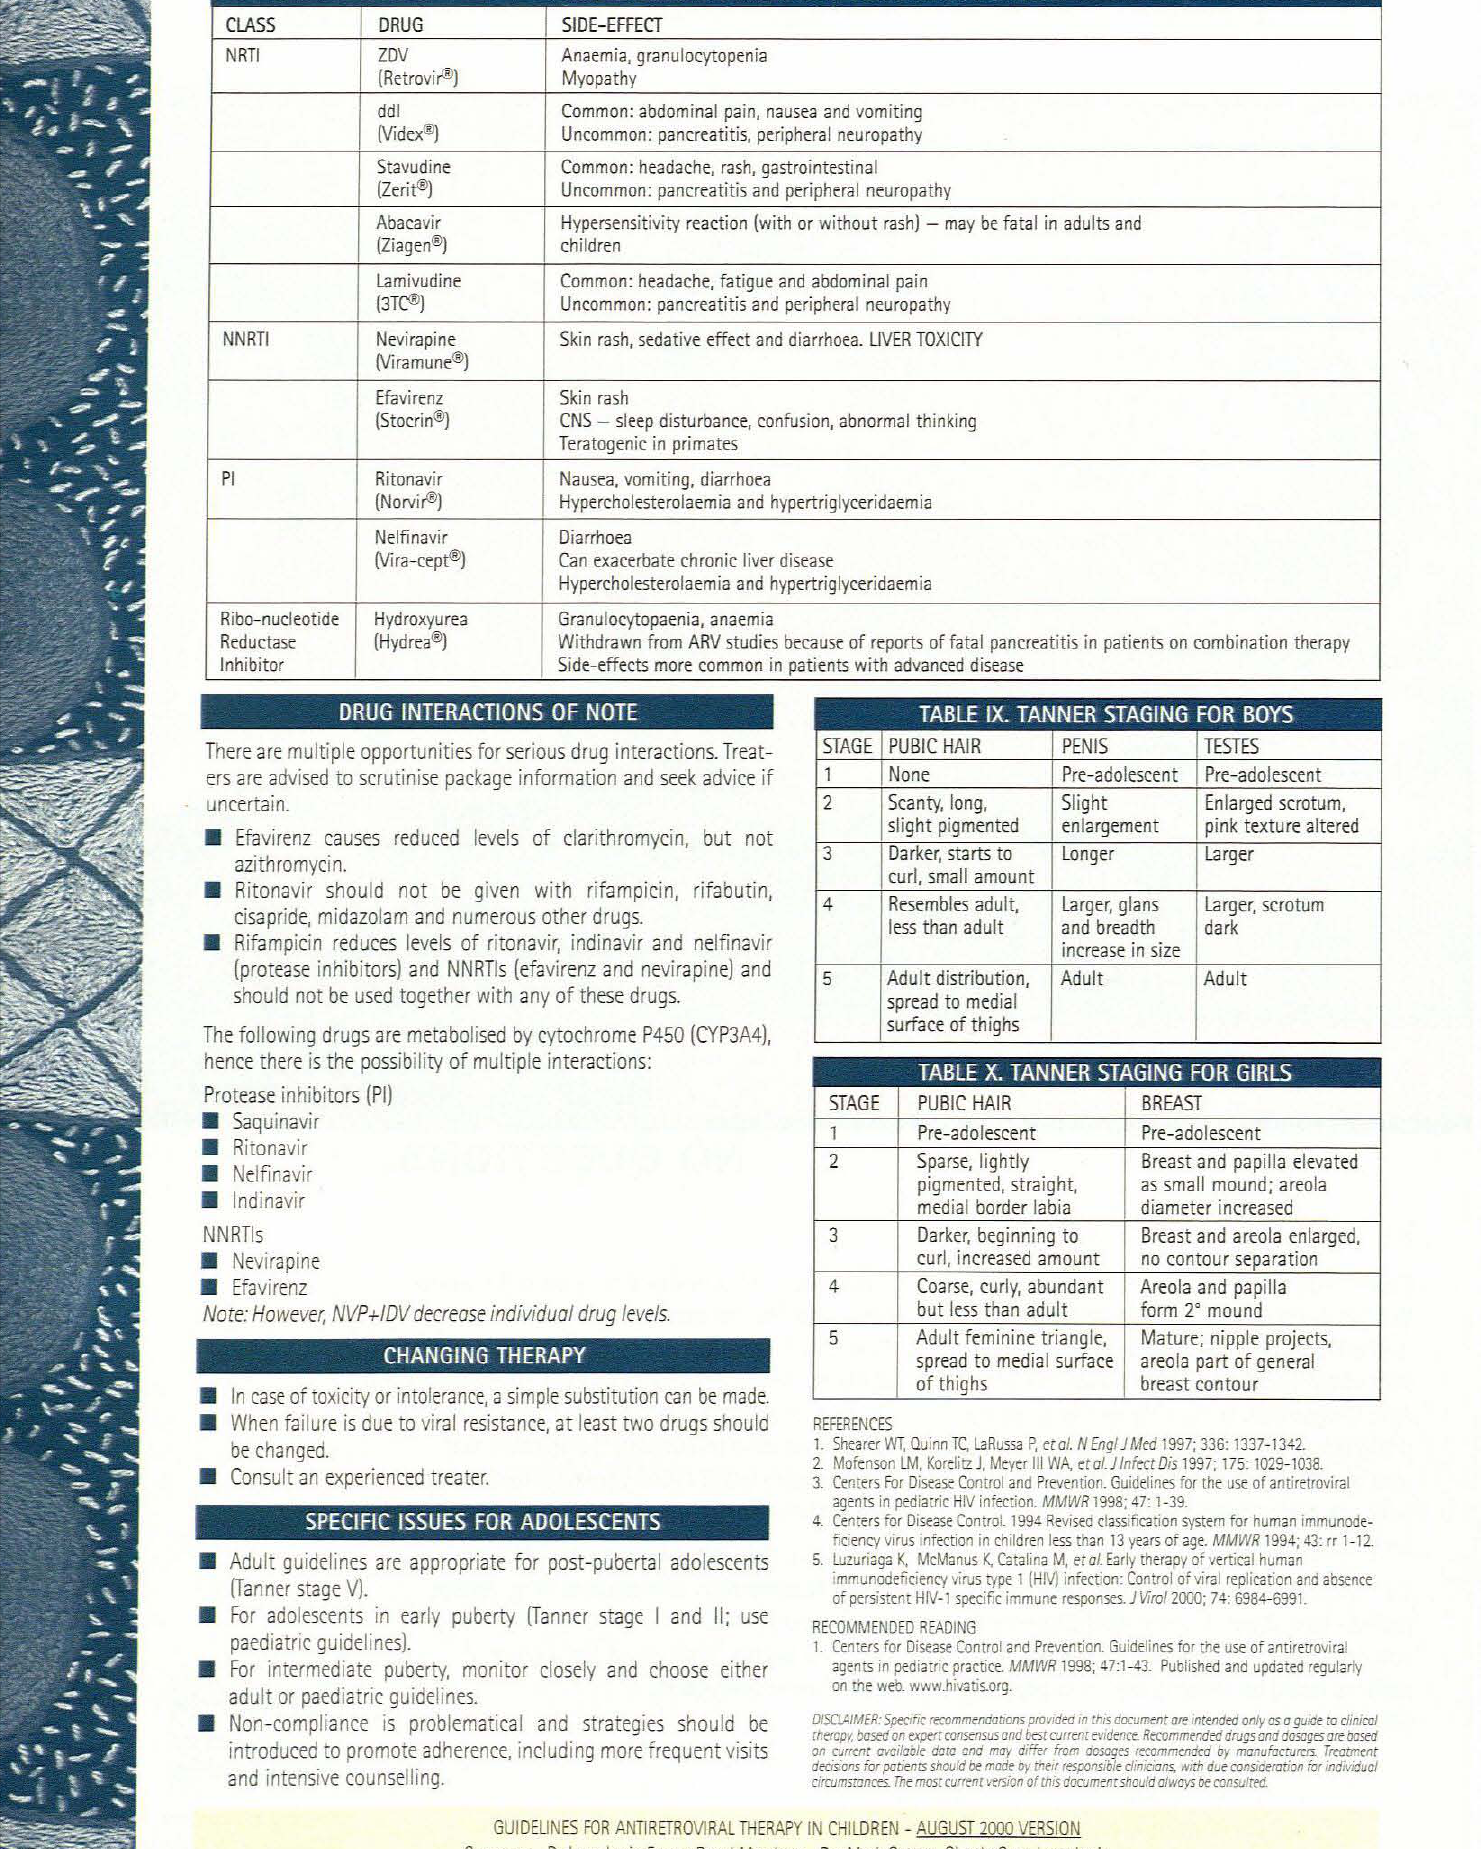
TABLE VIII. SIDE-EFFECTS OF ARVS IN CHILDREN